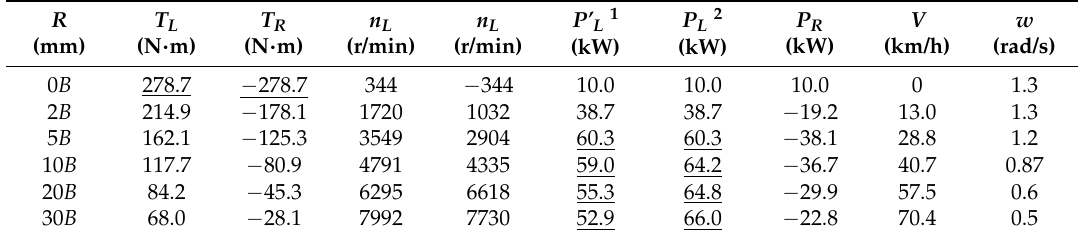
Table 3. Torque and power required by two motors in stationary